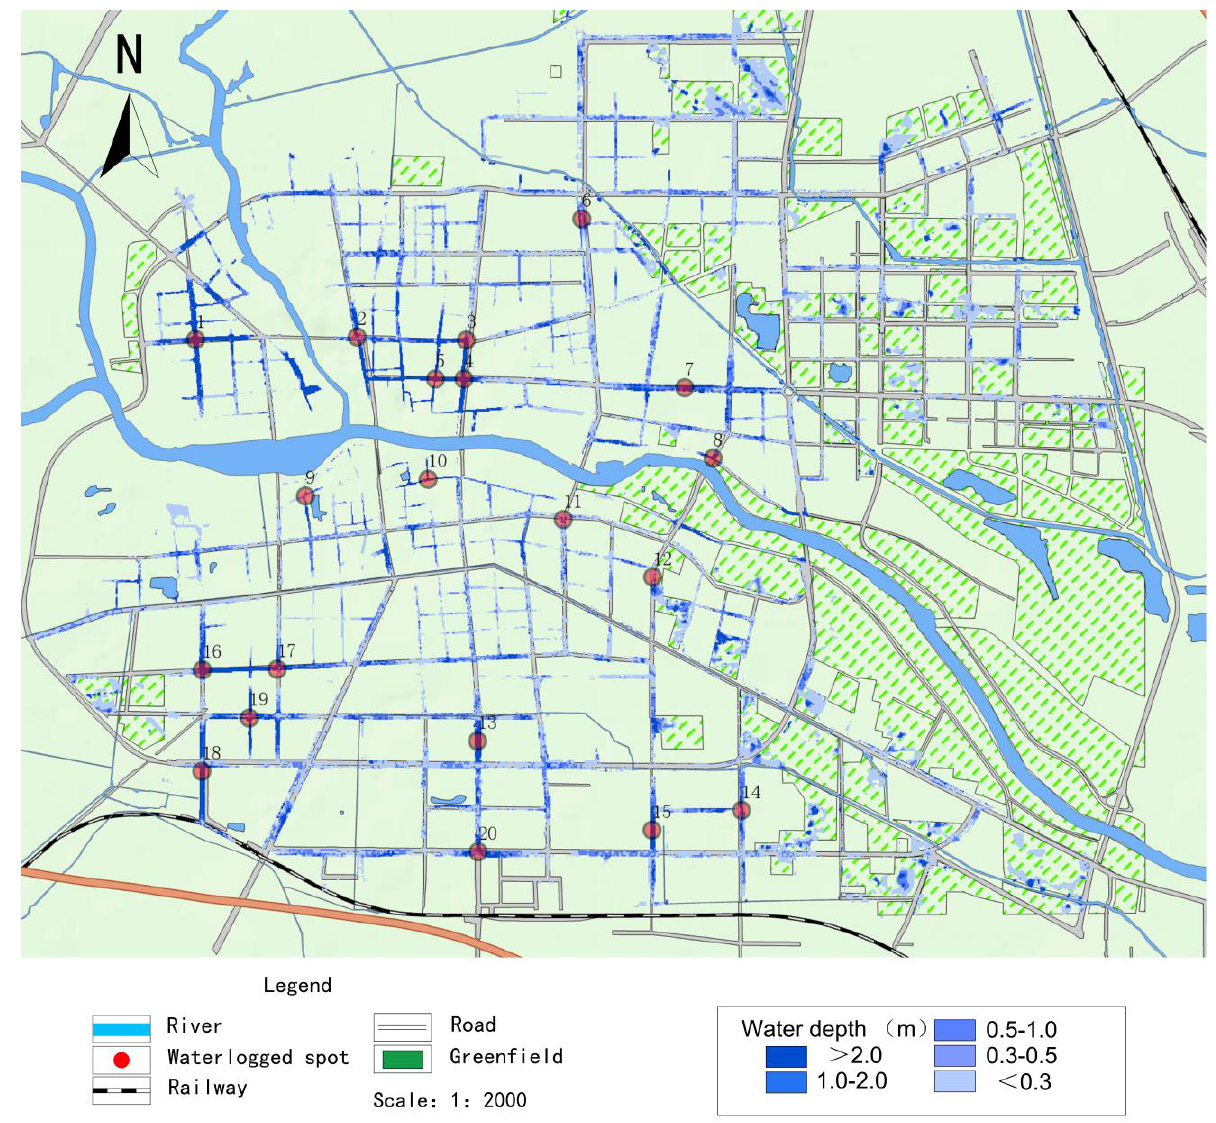
Figure 4. Distribution of major waterlogged sites for 20 July 2021.